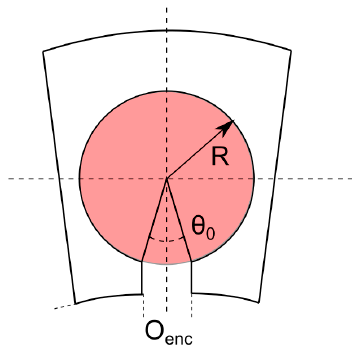
Figure 13. Analytical dimension of the slot opening.